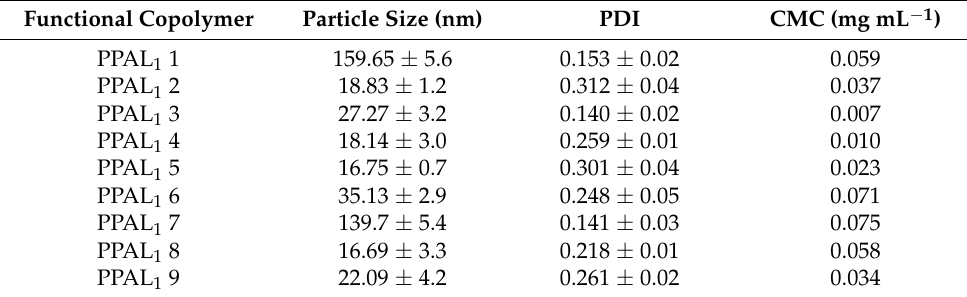
Table 3. Characterization of PPAL 1 1–9 copolymer nanoparticles.